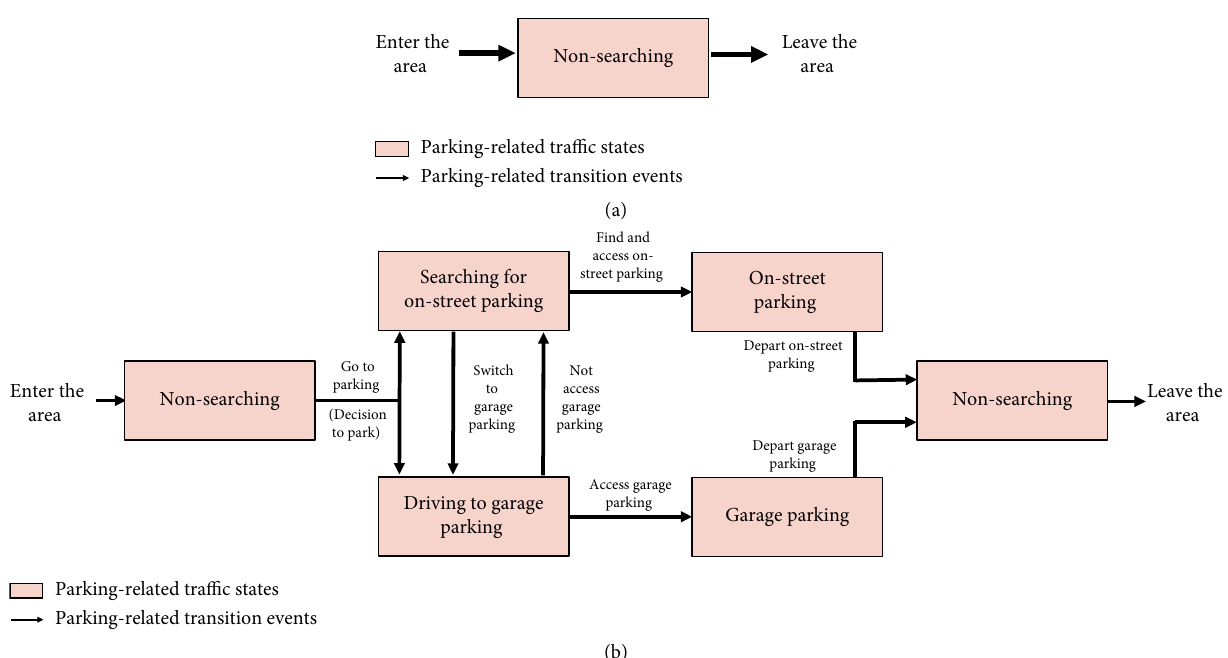
Figure 1: The transition events of urban traffic focusing on on-street and garage parking in-between different parking-related states. (a) Through-traffic. (b) Searching for parking